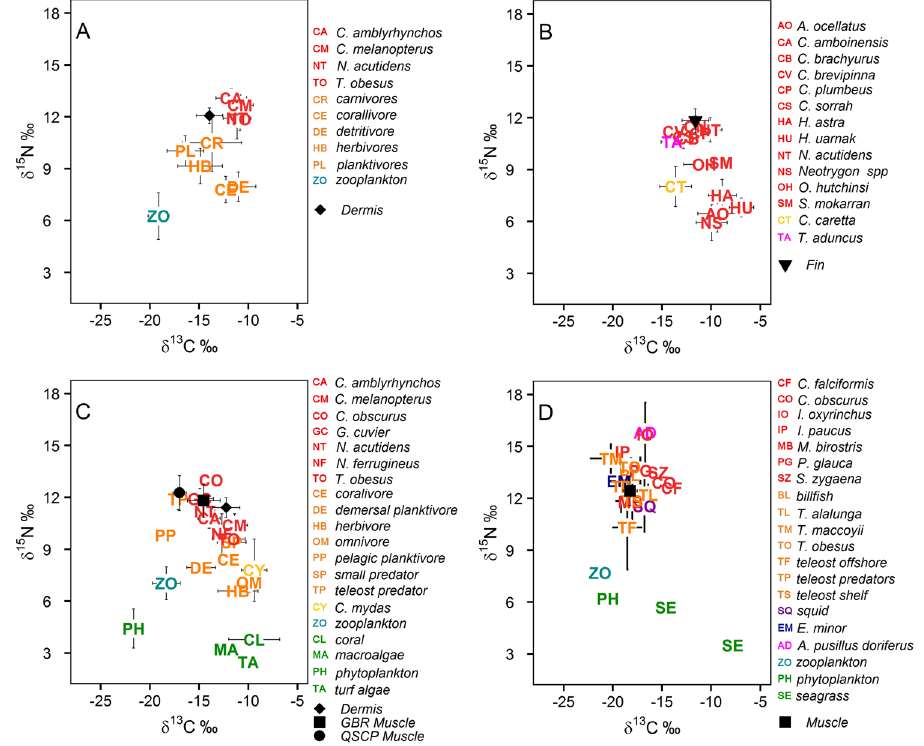
Figure 3. Mean isotope values ( ± SD) of slow turnover tissues (muscle, dermis, fin) of tiger sharks, other predators, consumers and primary producers at Ningaloo Reef, Shark Bay, Great Barrier Reef and New South Wales. Community data for each location was obtained from published studies 41, 55, 58, 61, 68, 86–90 and L. Zamora (unpublished data). Red = elasmobranchs, orange = teleosts, yellow = sea turtles, magenta = marine mammals, purple = cephalopods, light blue = zooplankton, green =